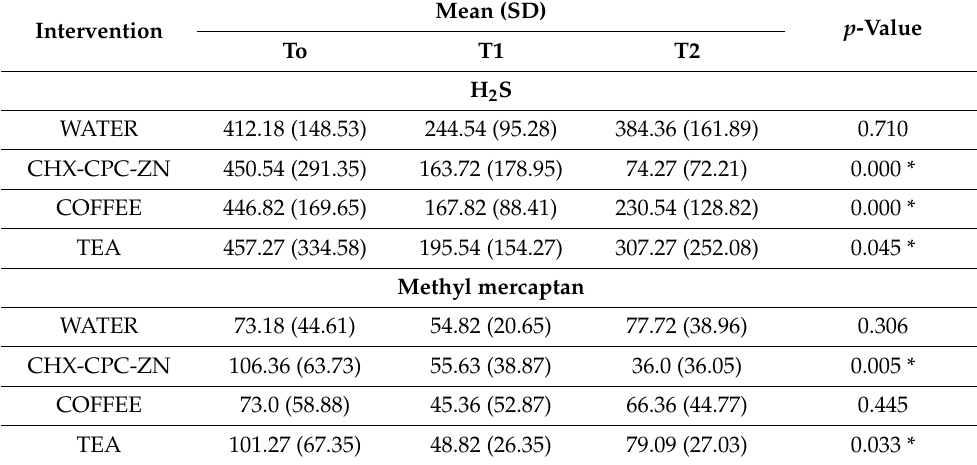
Table 2. Comparison of averages at three different times for each